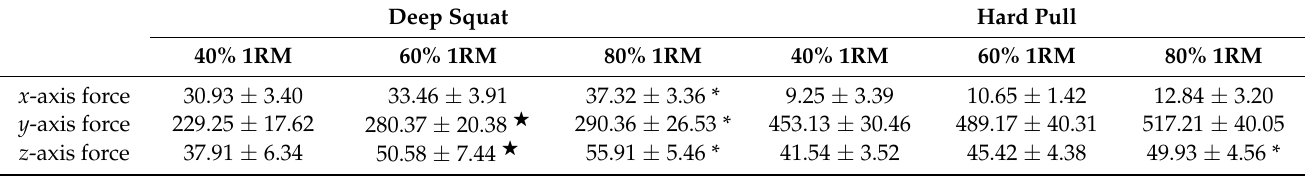
Table 6. Force on knee joint in different directions